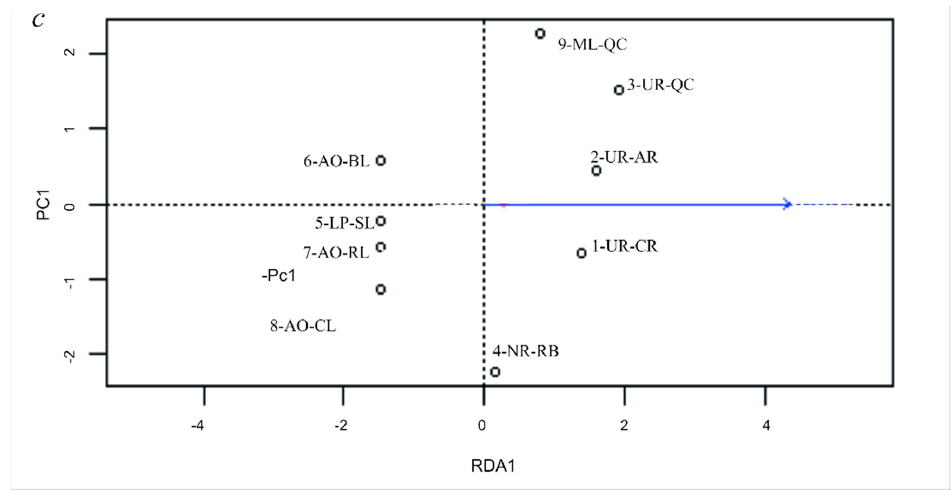
Figure 5. Redundancy analyses (RDA) of 9 locality samples in R. quelen based on Total dataset (14,820 loci) ( a ), Neutral dataset (13,213 loci) ( b ), or Outlier dataset (72 loci) ( c ) using the “maximum temperature of warmest month,” which was the most significant variable in all cases.